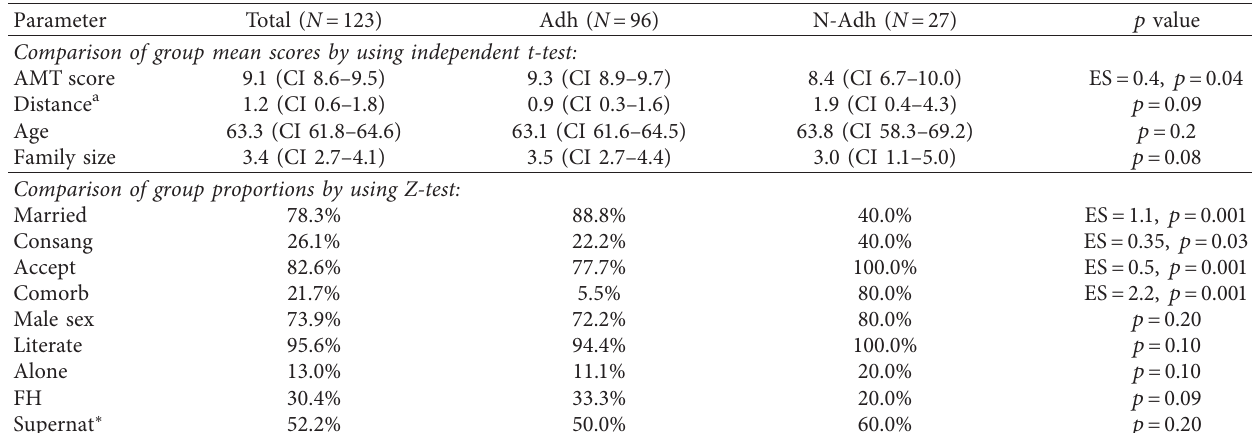
Table 1: Sociodemographic characteristics of participants assessed for medication beliefs and adherence to antiseizure medications. Parameter Comparison of group mean scores by using independent t-test: